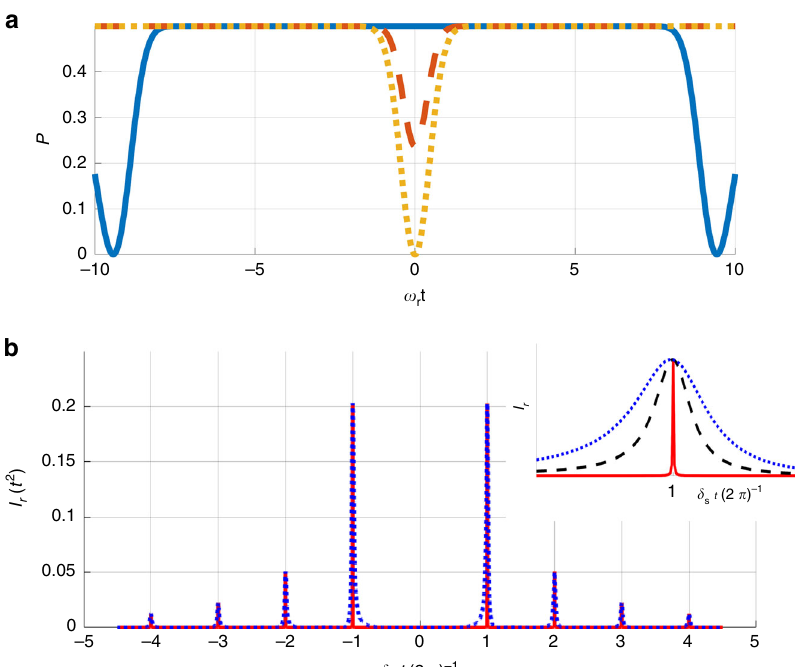
Fig. 3 Probability and Fisher information analysis. a Average transition probability ( p ) as a function of ω δ t ¼ 1 : 8 π (orange, dashed line) and δ s requirement is ful fi lled when δ illustrated in the inset: for ω and imperfections ” ). For this illustration: ω